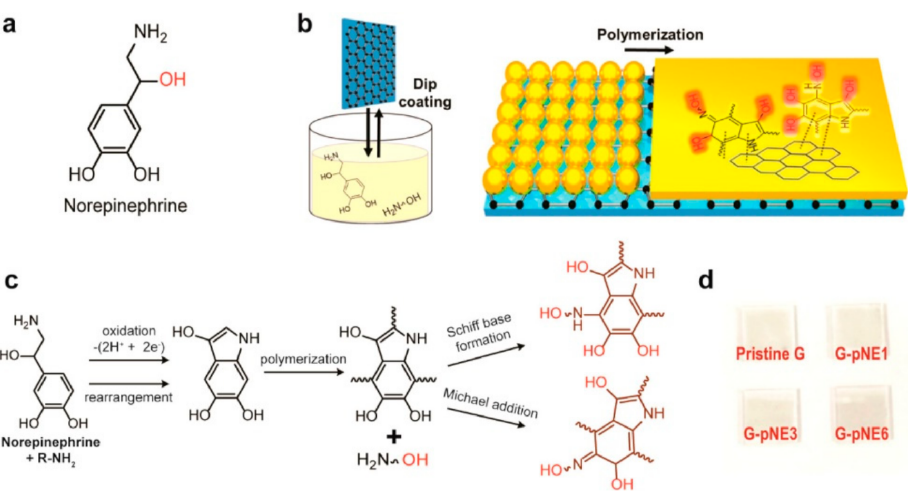
Figure 18. Formation of the polyNE film on graphene. ( a ) Molecular structure of norepinephrine. ( b ) Schematic of the process of coating and polymerization of norepinephrine on graphene. ( c ) Scheme for the polymerization pathway of norepinephrine. ( d ) Digital image of pristine and pNE-coated graphene on glass substrates. Reproduced from [121] with the permission of the American Chemi- cal